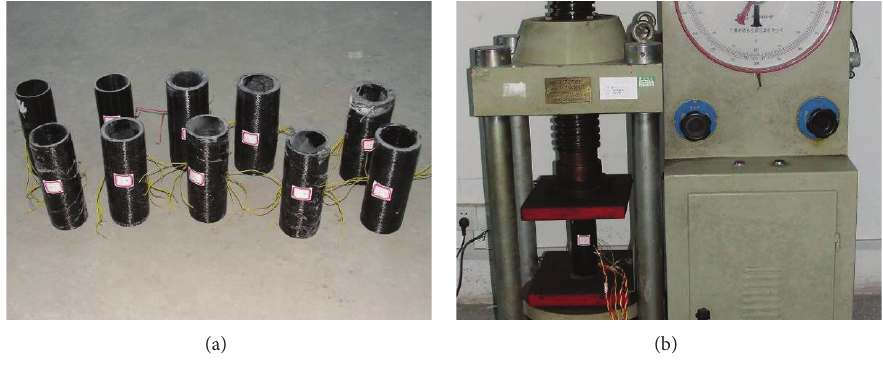
Figure 1: Test preparation of (a) specimens; (b) testing.